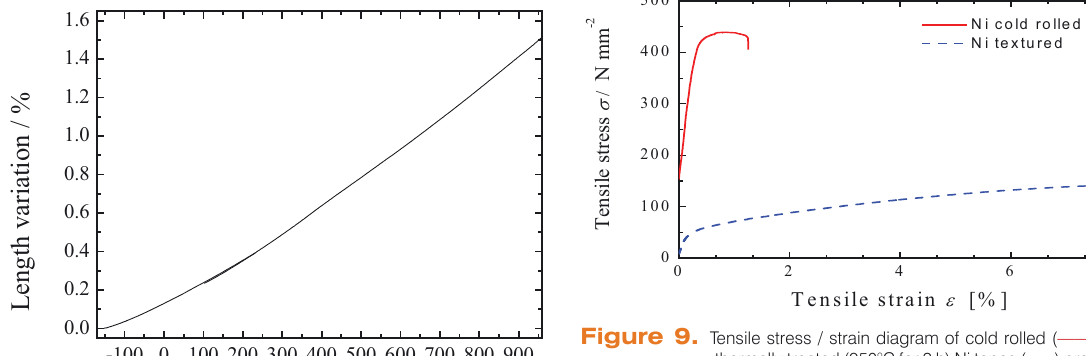
Figure 9. Tensile stress / strain diagram of cold rolled ( ——) and thermally treated (950°C for 2 h) Ni tapes (-----) prepared from commercially used Ni.